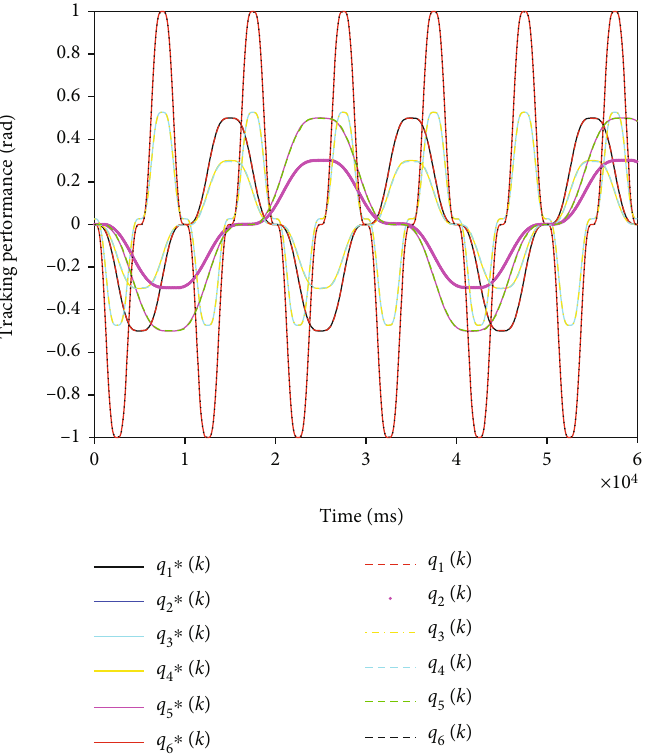
Figure 7: Tracking performance of each robotic joint controlled by cascaded PD plus.